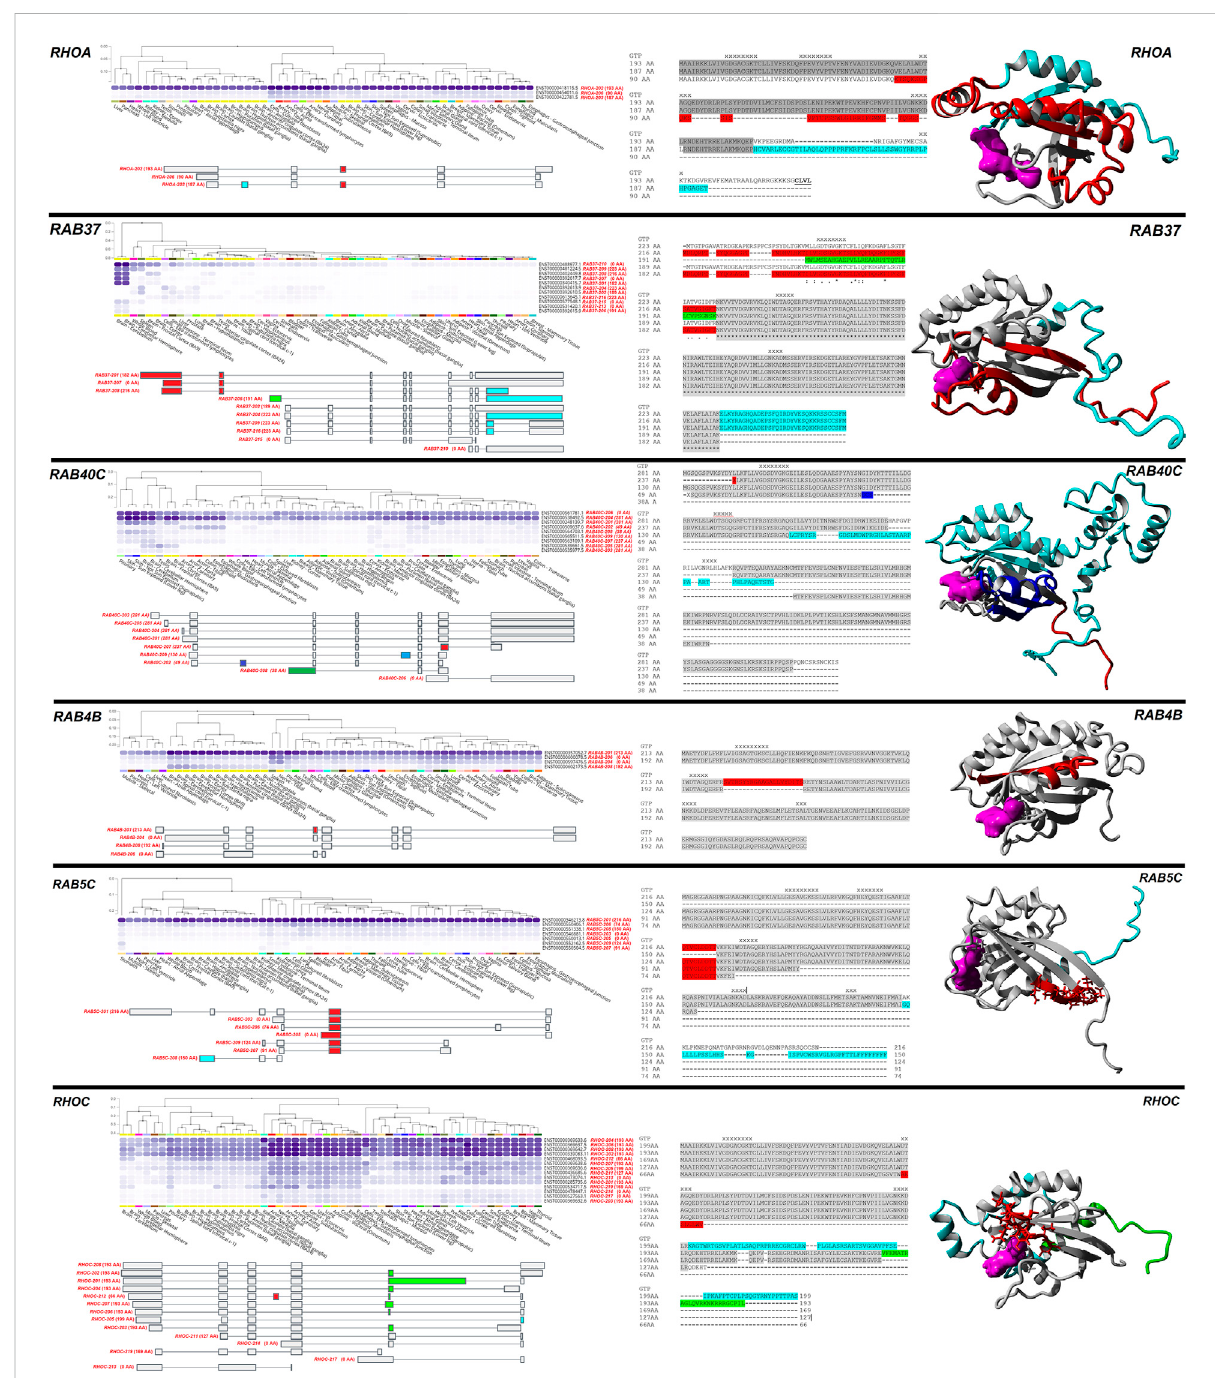
FIGURE 5 Examples of protein-changing isoforms with tissue-based dynamics. Six genes/proteins are shown ( RHOA , RAB37 , RAB40C , RAB4B , RAB5C , RHOC ), with a black line separating them. For each gene/protein, the top left panel shows different isoform expressions in human tissues, with dark bluethehighestexpression.Ensembleidenti fi ersarelabeledinblackforeachisoformandgenetranscriptwithAAsizeinbracketslabeledinred.This imageis modi fi edfrom theGTEx websitefor each gene. Below theGTEx expression data isisoform splicing, with colored regions changingthe protein sequence. In the middle of each gene are the sequence alignments for the different proteins with color highlights corresponding to the splicingmap.TheGTP/GDPbindingsitesaremarkedwithanX.Totherightisaproteinmodel,withcolorsidentifyingthesitesinthealignment.GTP/ GDP are colored